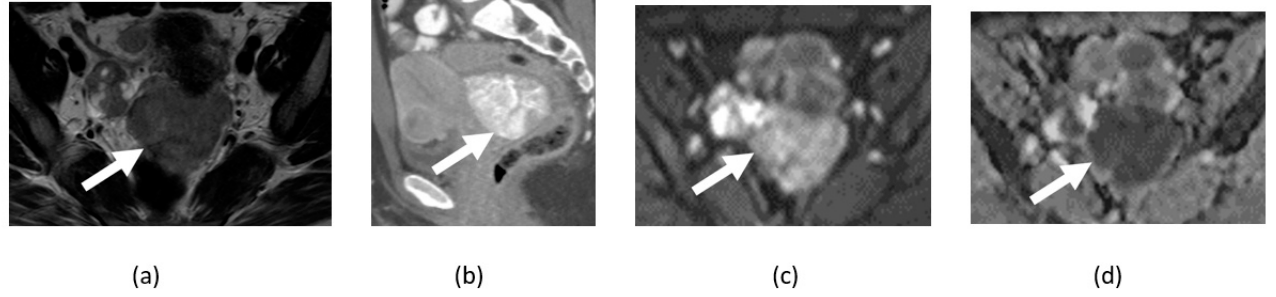
Figure 17. Axial T2-weighted image ( a ) and sagittal contrast-enhanced CT image ( b ) show posterior pelvic lobulated solid mass (arrows) from biopsy serous ovarian tumor with diffusion restriction on corresponding DWI ( c ) and ADC maps ( d ).